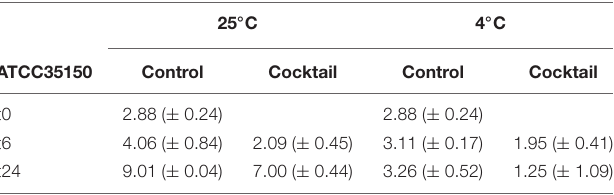
TABLE 3 | Average of ATCC35150 microbial count of three replicates at three time, at two different temperature express in log